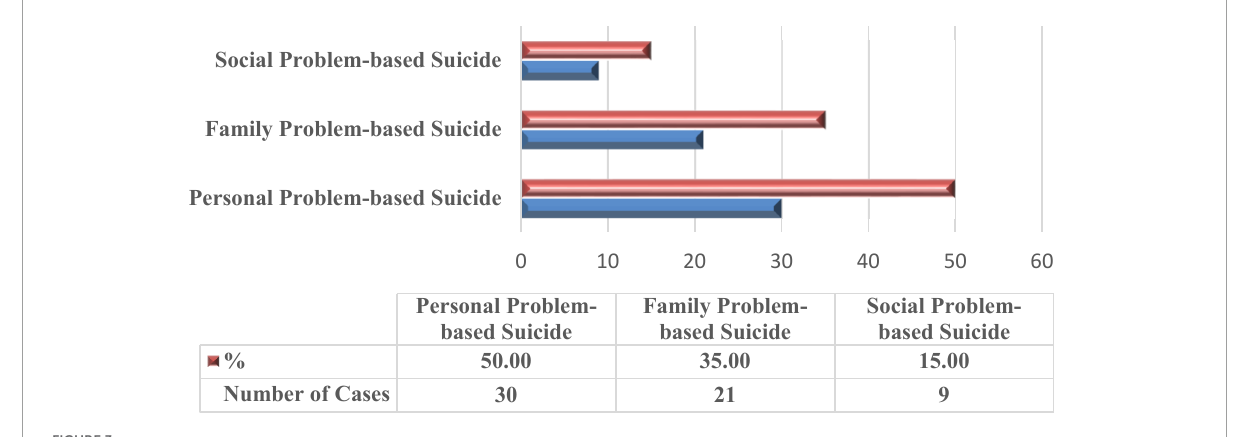
FIGURE3 Nature of suicide among older